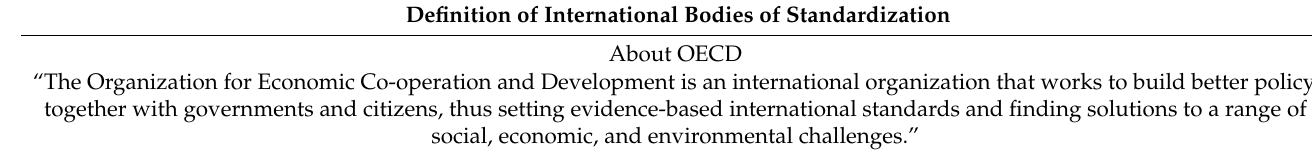
Table 6. Definition of international bodies of standardization.